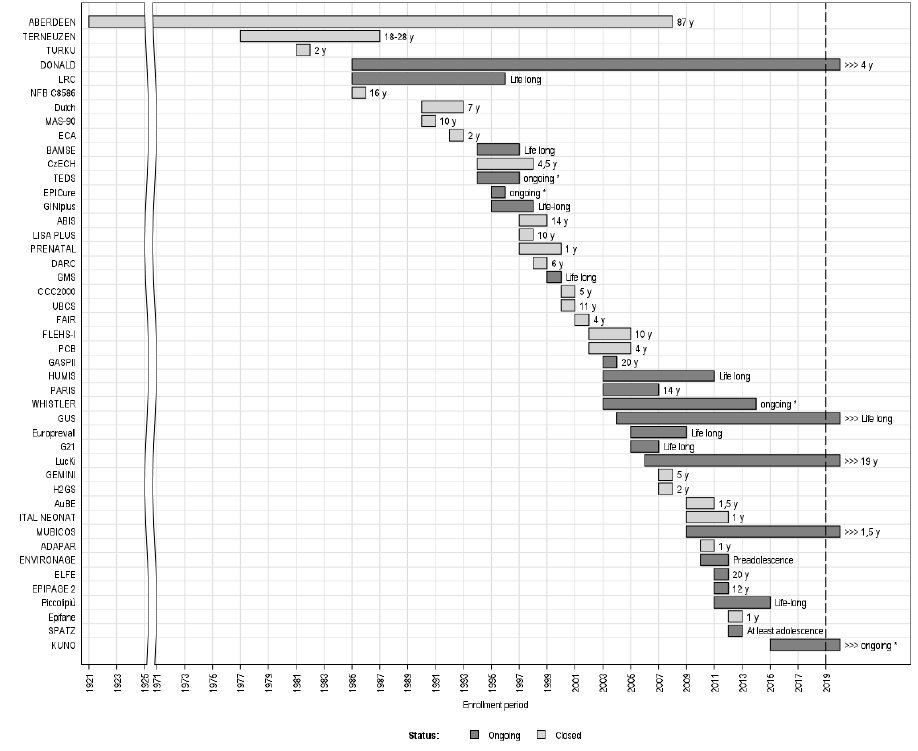
Figure 4. The 45 cohorts and their enrolment period, follow-up status (Ongoing/Closed), and duration (years). X-axis: enrollmentperiod; y-axis: cohorts’names / acronyms. *Nospecificfollow-uptermination (years). X-axis: enrollment period; y-axis: cohorts’ names/acronyms. * No specific follow-up date.; termination date.; y-years.